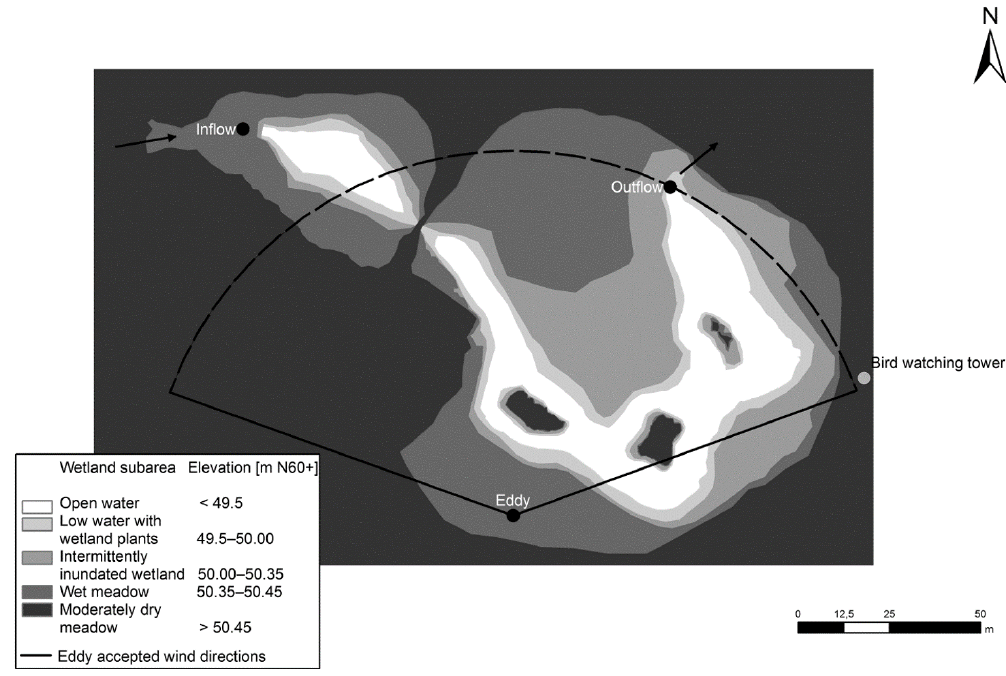
Figure 1. The landscape classification of the Nummela wetland. Wetland subareas specified according to mean water level are shown with different colours. The arrows indicate the direction of the water flow. The black dots indicate the inflow and outflow measuring stations and the location of the EC